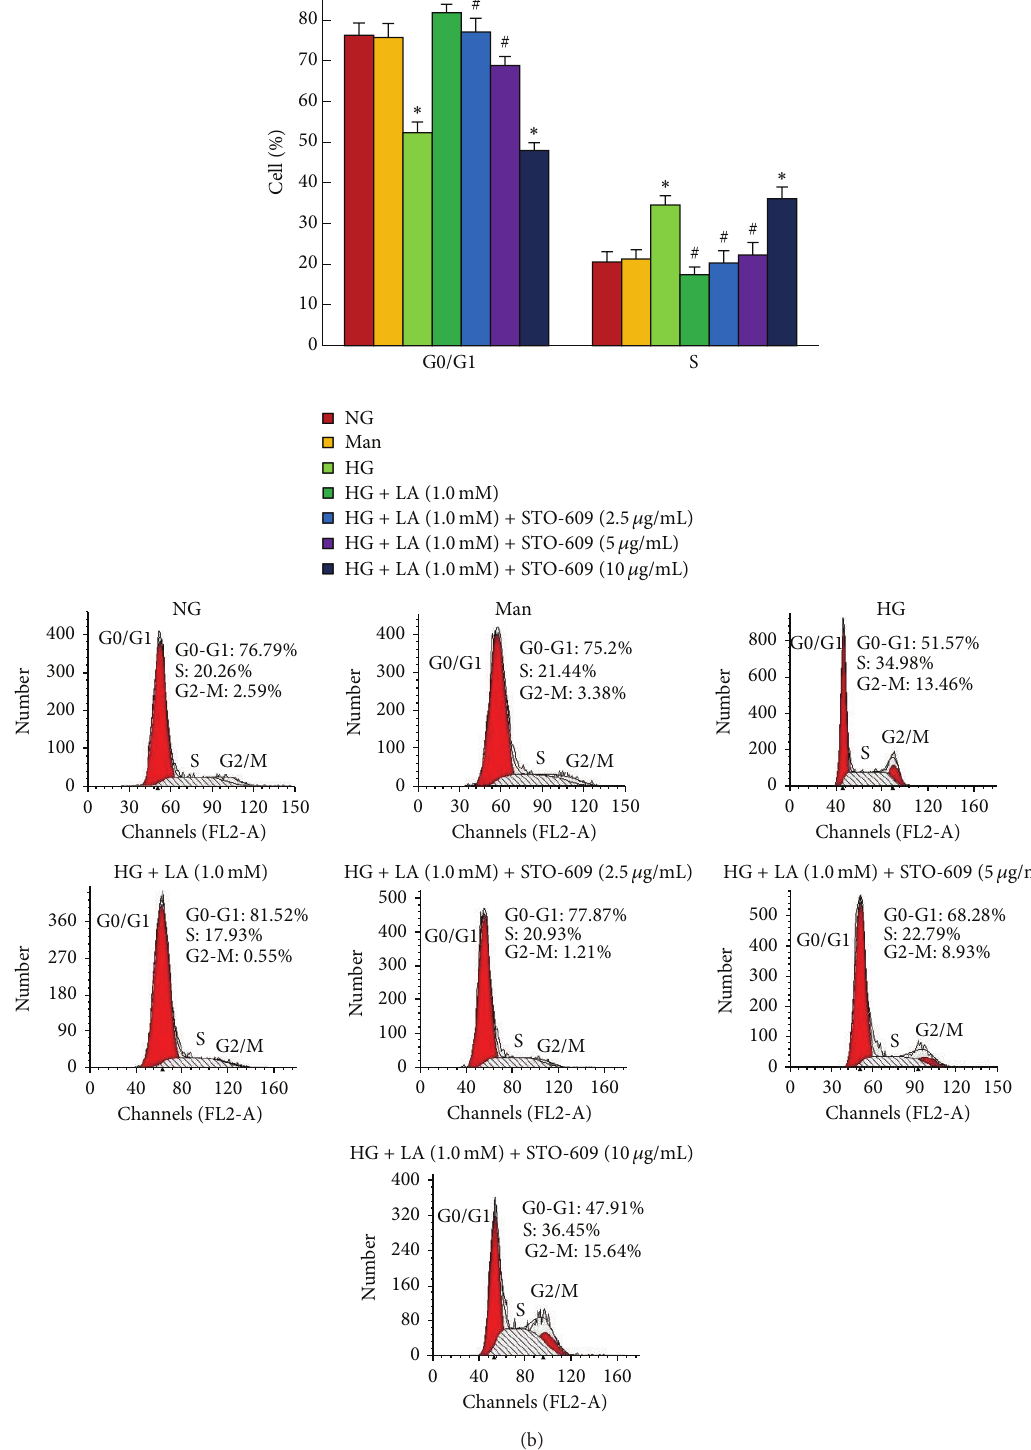
Figure7:LY294002inhibitedcell-cycleprogressioninducedby0.25 mMLAinhighglucose-culturedMCs.STO-609preventedtheinhibition of high glucose-stimulated mesangial cell-cycle progression caused by 1.0mM LA. MCs were pretreated with high glucose (30mM) for 1h and then incubated with LY294004 (0, 2.5, 5, 10 𝜇 mol/L) plus 0.25 mM LA or STO-609 (0, 2.5, 5, 10 𝜇 g/mL) plus 1.0mM LA, respectively, for an additional 24 h. Cells were analyzed by flow cytometry after PI staining. Data in the bar graphs represent the mean ± SD ( 𝑛 = 3 ). 𝑃 <